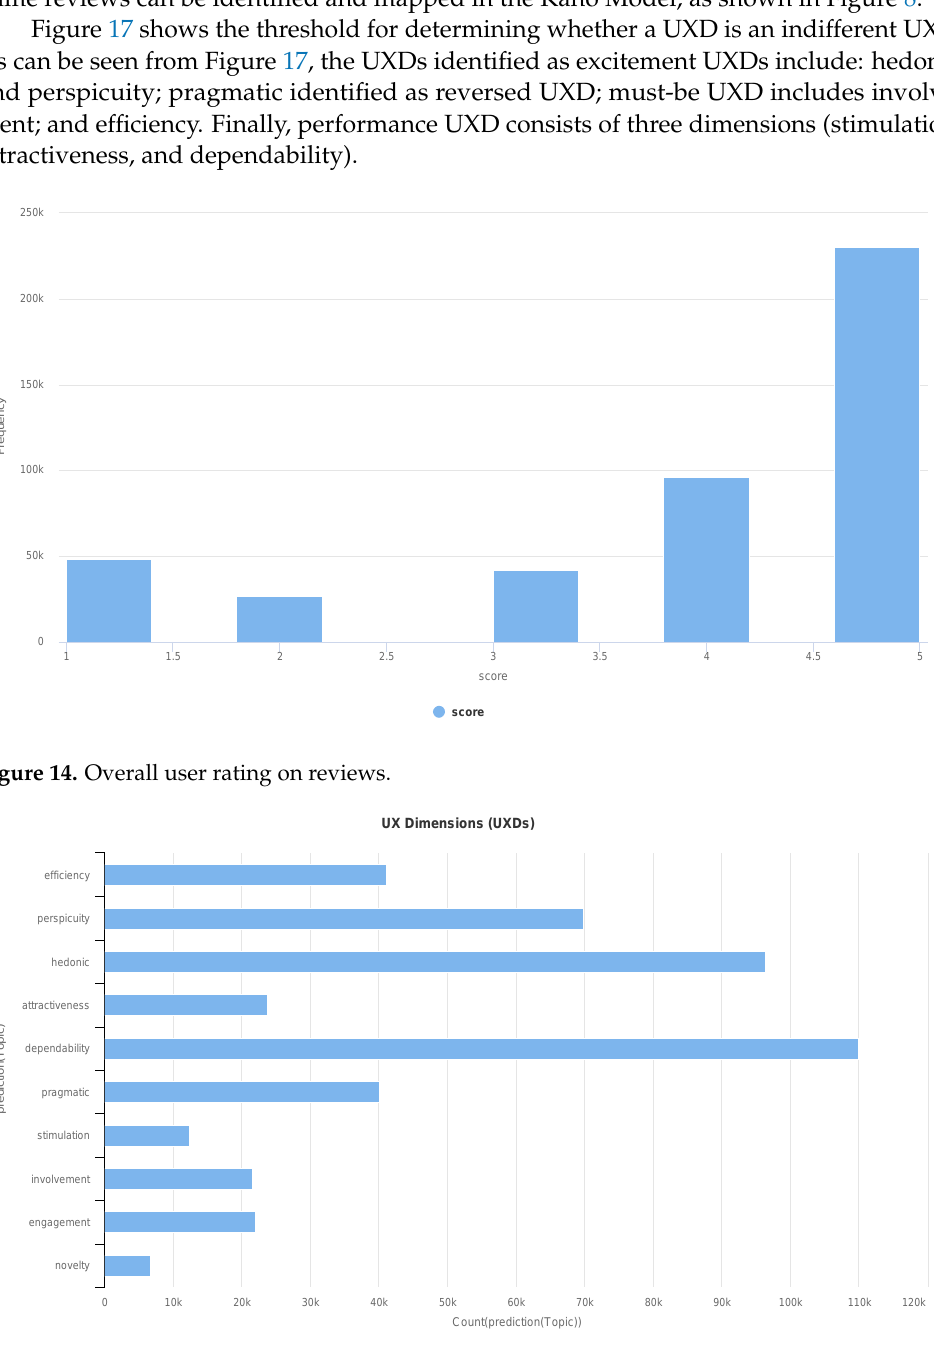
Figure 15. Extracted UX dimensions from user